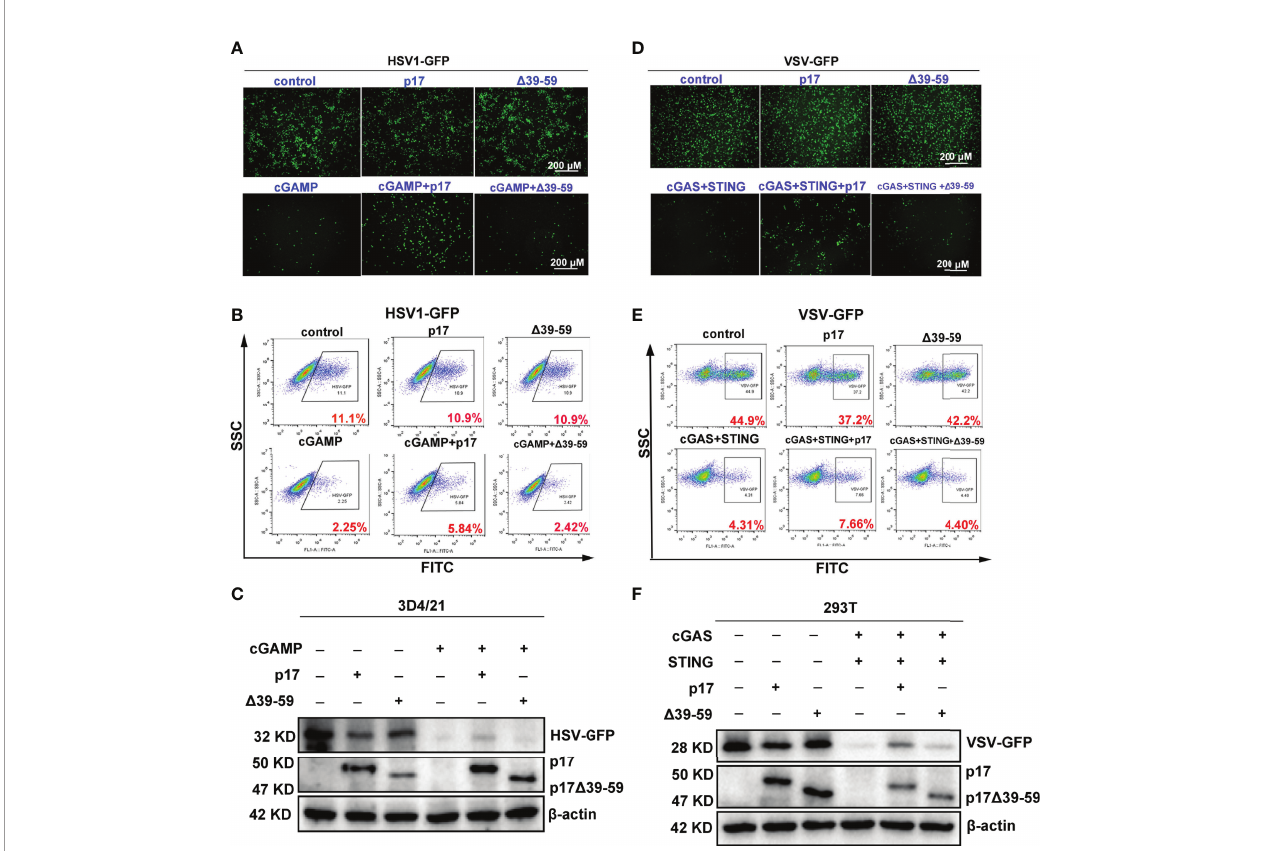
FIGURE 9 | Effects of p17 △ 39-59 on the cGAS-STING signaling mediated anti-HSV1 and anti-VSV responses. (A-C) The p17 (0.5 m g) or △ 39-59 (0.5 m g) was transfected into 3D4/24 cells for 12 h, and the stimulated with transfection of 2 ’ 3 ’ -cGAMP (2 m g/mL) for 12h. The cells were infected with HSV1-GFP at the MOI of 0.01 for 20 h. The HSV1 replicative GFP signals were visualized by fl uorescence microscopy (A) , the HSV1-GFP infected cells were analyzed by fl ow cytometry (B) and the viral GFP protein expressions were detected by Western blotting (C) . (D – F) The p17 (0.5 m g) or △ 39-59 (0.5 m g) plus porcine cGAS (0.5 m g) and STING (0.5 m g) were co-transfected into 293T cells for 12 h. The cells were infected with VSV-GFP at the MOI of 0.001 for 8 h. The VSV replicative GFP signals were visualized by fl uorescence microscopy (D) , the infected cells were analyzed by fl ow cytometry (E) and the viral GFP protein expressions were analyzed by Western blotting (F)